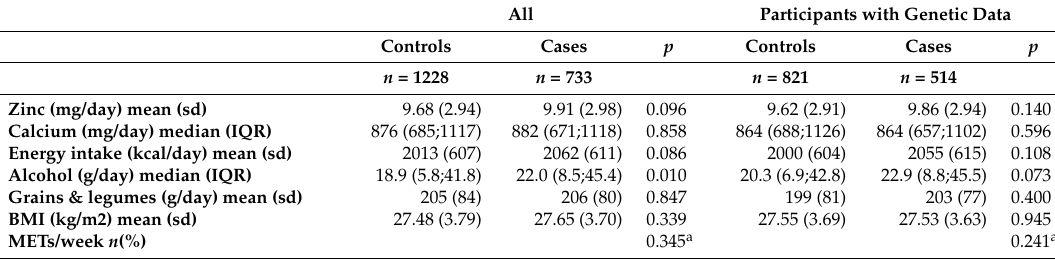
Table 1. Characteristics of participants in case-control MCC-Spain study. All Participants with Genetic Data Controls Cases p Controls